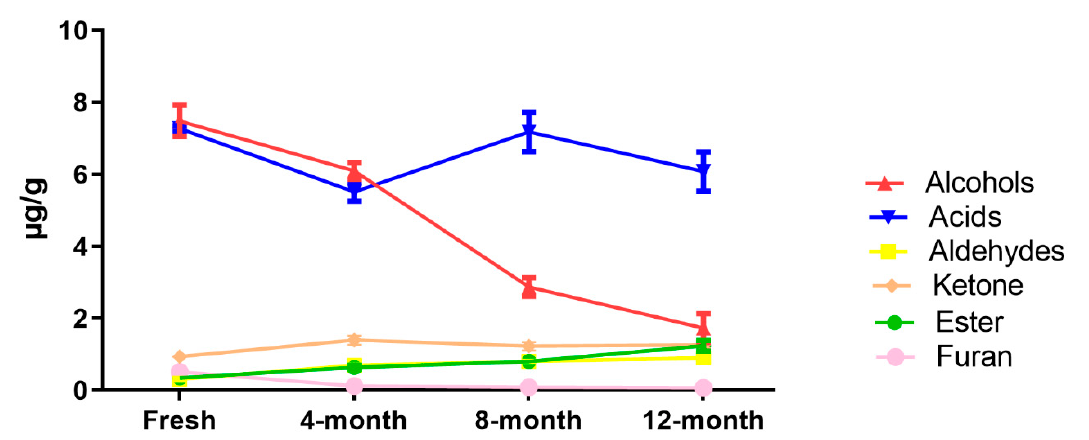
Figure 4. Post-storage changes of different classes of fatty acid-derived compounds in air-dried raisins.